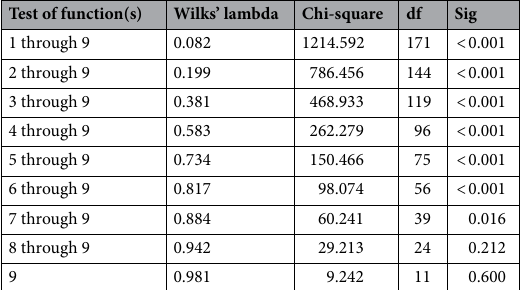
Table 2. Canonical discriminant analysis efficiency parameters to determine the significance of each canonical discriminant function. df degrees of freedom.